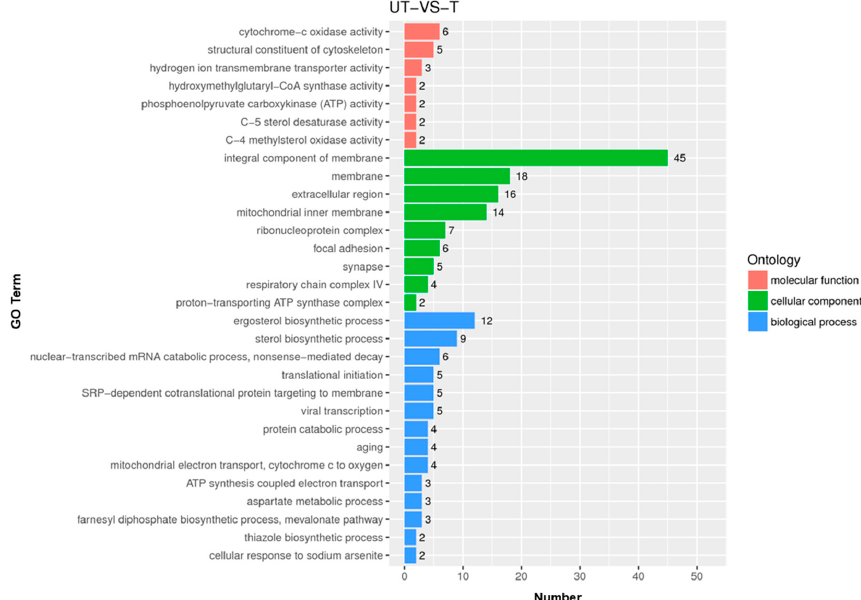
Figure 3. Gene ontology (GO) annotations of the 30 most prominent GO terms enriched in DEGs grouped into three main GO categories: cellular component (117), biological process (67), and mo- lecular function (22).